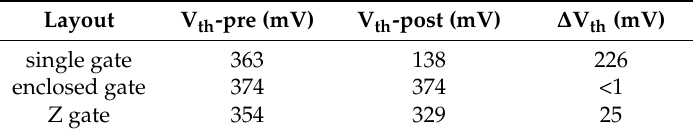
Table 2. V th in the pre- and post-radiation scenarios.